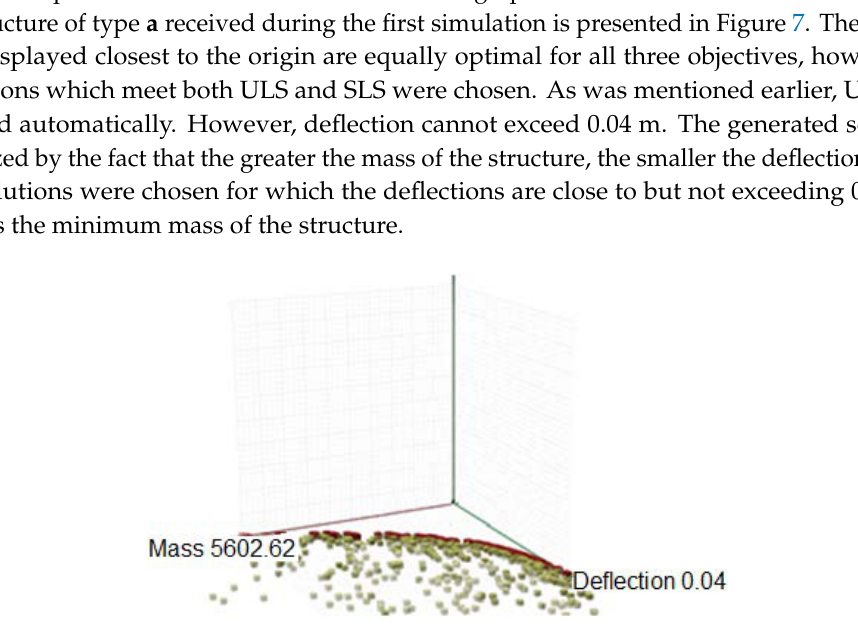
Figure 7. The 2D graph of the Pareto front for the hyperbolic paraboloid canopy structure with pattern a (split along the short diagonal—division into eight parts).